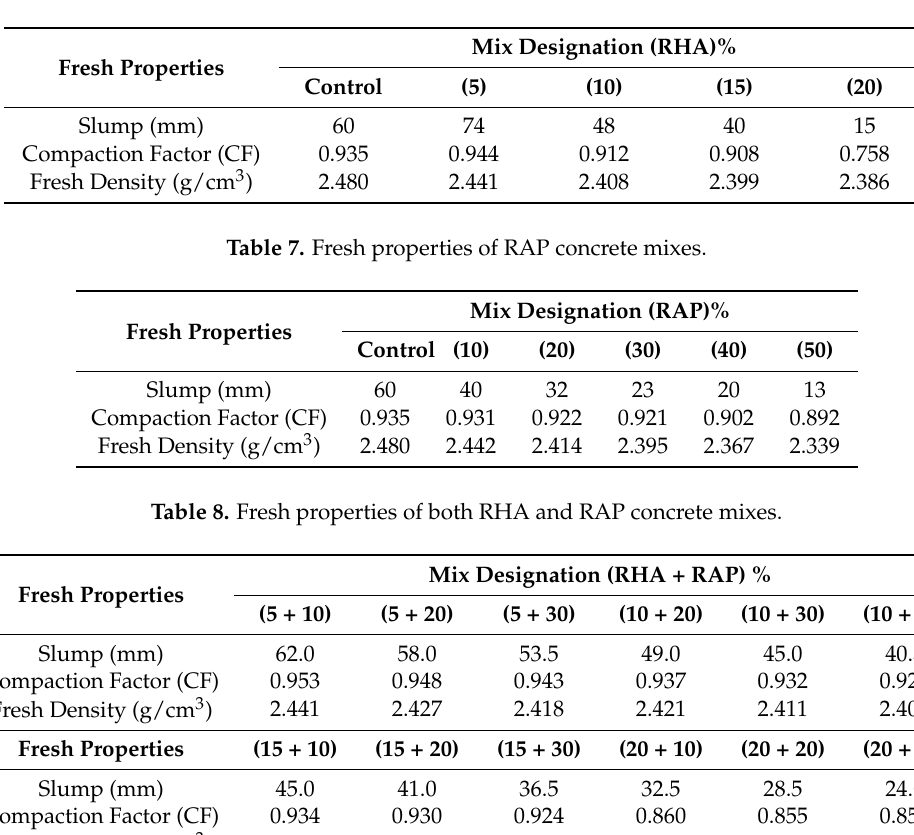
C = 0.82S 0.032 f R² = 0.965